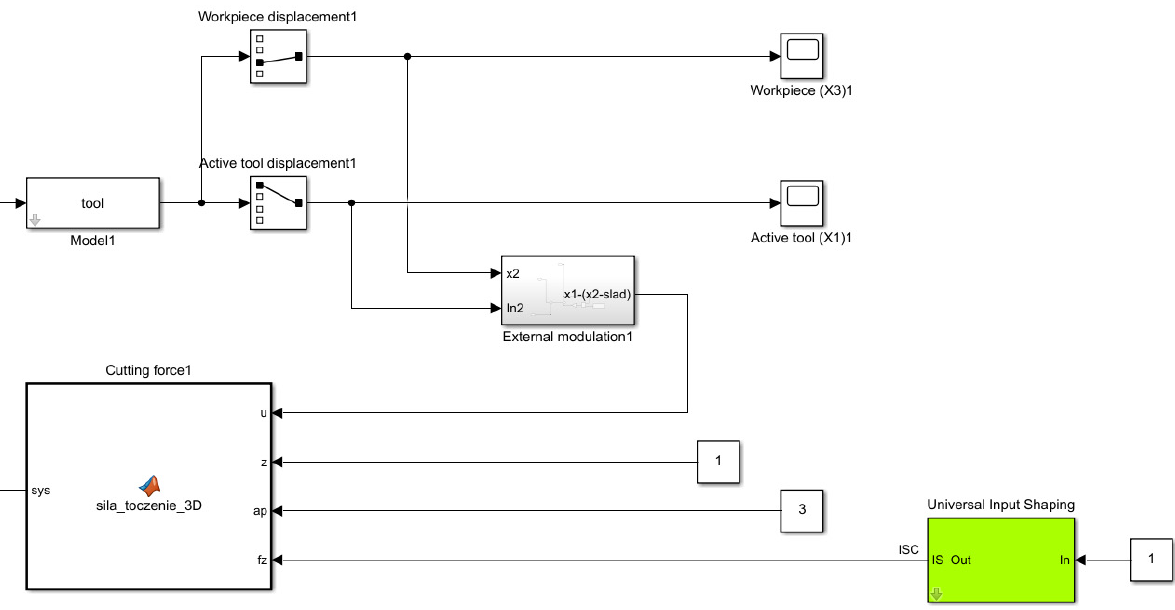
Figure 7. Summary of the recorded response of the system (blue line) with marked peaks of indi- vidual amplitudes (red markers) and the damping dynamics curve (black line).